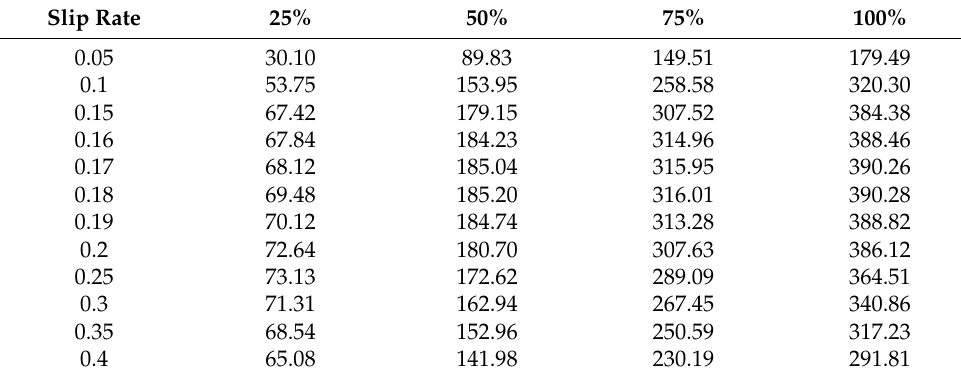
Table 2. Average output torque at different coupling ratio(N ·